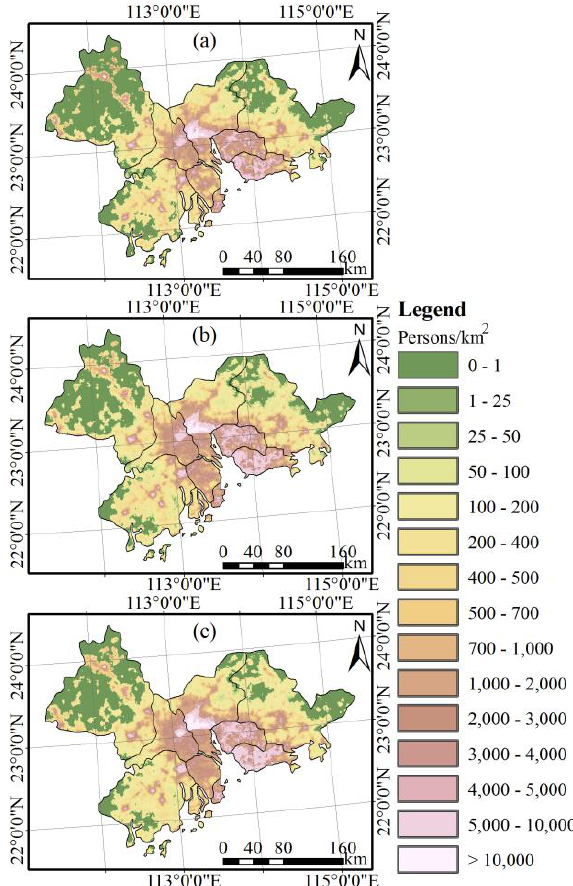
Figure 3. Estimated population at 1 km * 1 km scales from 2000 to